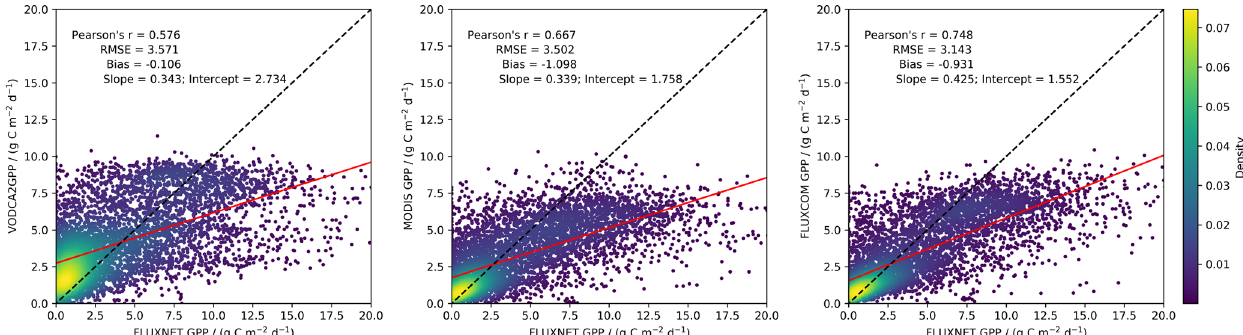
Figure A2. GPP from FLUXNET plotted against GPP from VODCA2GPP, MODIS, and FLUXCOM for the period 2002–2016 with monthly